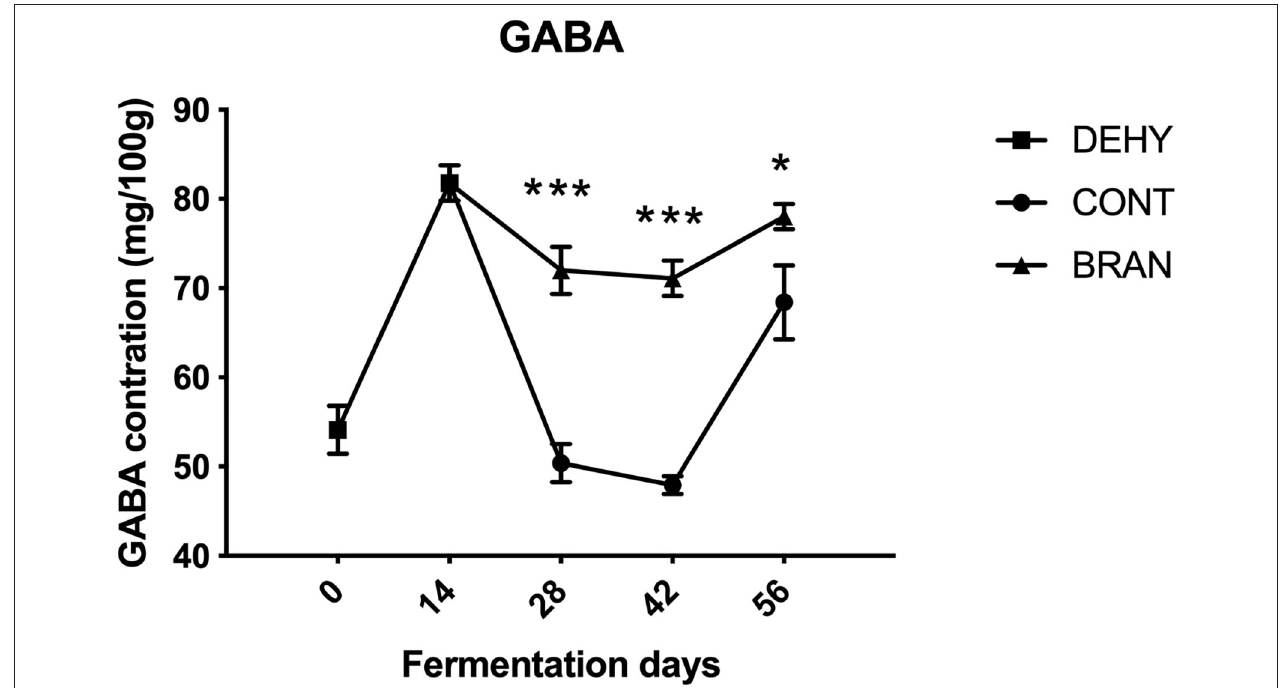
FIGURE 2 | Changes in GABA concentration during pickling of the radish roots. DEHY: dehydration stage, at 0 (start of dehydration) and 14 days, CONT: seasoning stage (days 28, 42, and 56) of the fermented radishes without wheat bran, and BRAN: seasoning stage (days 28, 42, and 56) of fermented radishes with wheat bran. The data are presented as mean ± SD (n = 3), and significant differences within each seasoning period between CONT and BRAN are marked as * p < 0.05, *** p < 0.001. 56th, riboflavin content in the CONT group surpassed that of the BRAN group (22.1 vs. 20.4 µ g/100 g, p =